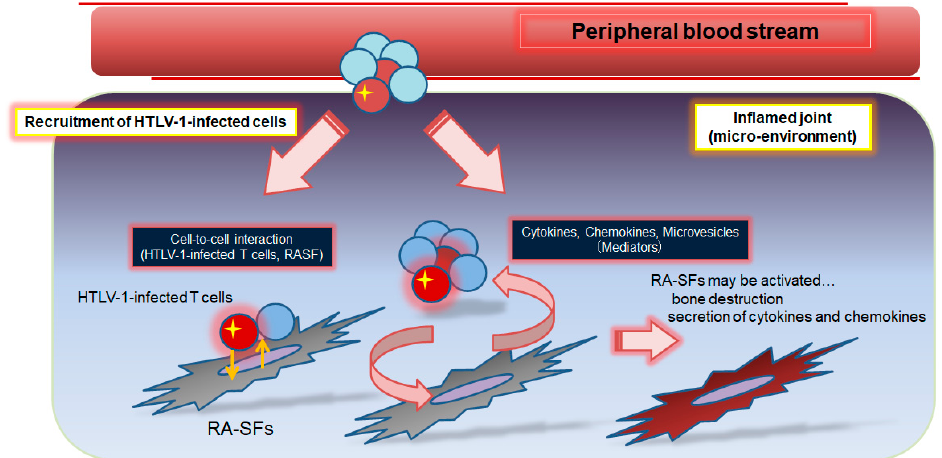
Figure 1. Hypothesis of the pathogenesis in the worsening of inflammation in HTLV-1-positive patients with rheumatoid arthritis (RA). Several reports have indicated that HTLV-1-infected T cells infiltrate the inflamed joints of patients with RA. These HTLV-1-infected T cells reportedly exhibit autonomous proliferation and release cytokines and chemokines via HTLV-1-associated proteins, such as Tax and HBZ. Therefore, it is possible that there are interactions between HTLV-1-infected T cells and RA synovial fibroblasts (RA-SFs).